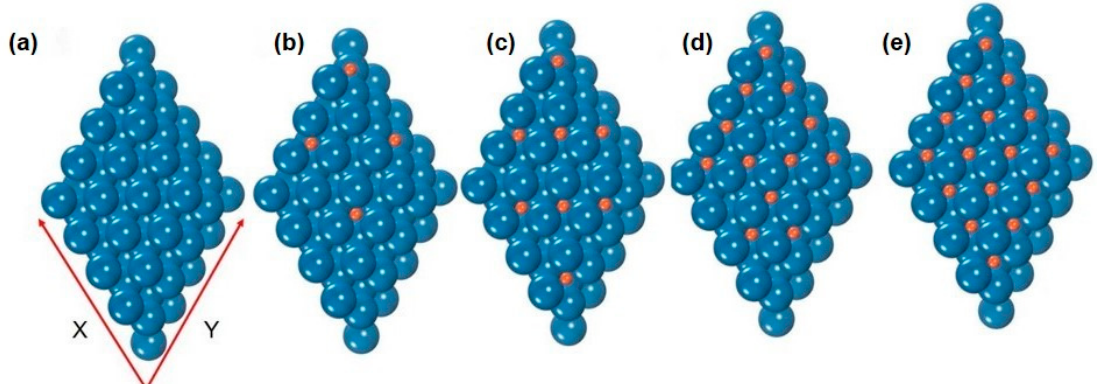
Figure 3. Schematic diagram of hydrogen atoms on the Pt (111) surface with 0% ( a ), 25% ( b ), 50% ( c ), 75% ( d ), and 100% ( e ) fcc-H coverage. The blue and orange balls represent the Pt and H atoms, respectively.